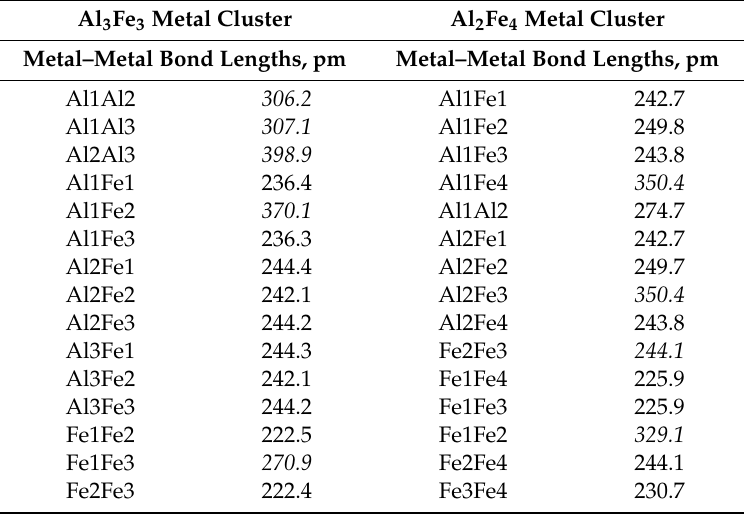
Table 9. Key structural parameters of most stable Al 3 Fe 3 and Al 2 Fe 4 metal clusters *